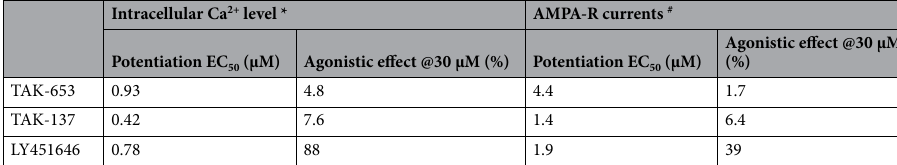
Table 1. Effects on intracellular Ca 2+ level and AMPA-R-mediated currents in the presence or absence of AMPA in rat primary hippocampal neurons. *% of 5 μM AMPA + 10 μM HBT1 response. # % of AMPA (100 μM)-induced steady-state response. EC 50 value was calculated from dose-response curve in the presence of 5 μM AMPA for intracellular Ca 2+ levels or 1 μM AMPA for AMPA-R currents using a nonlinear